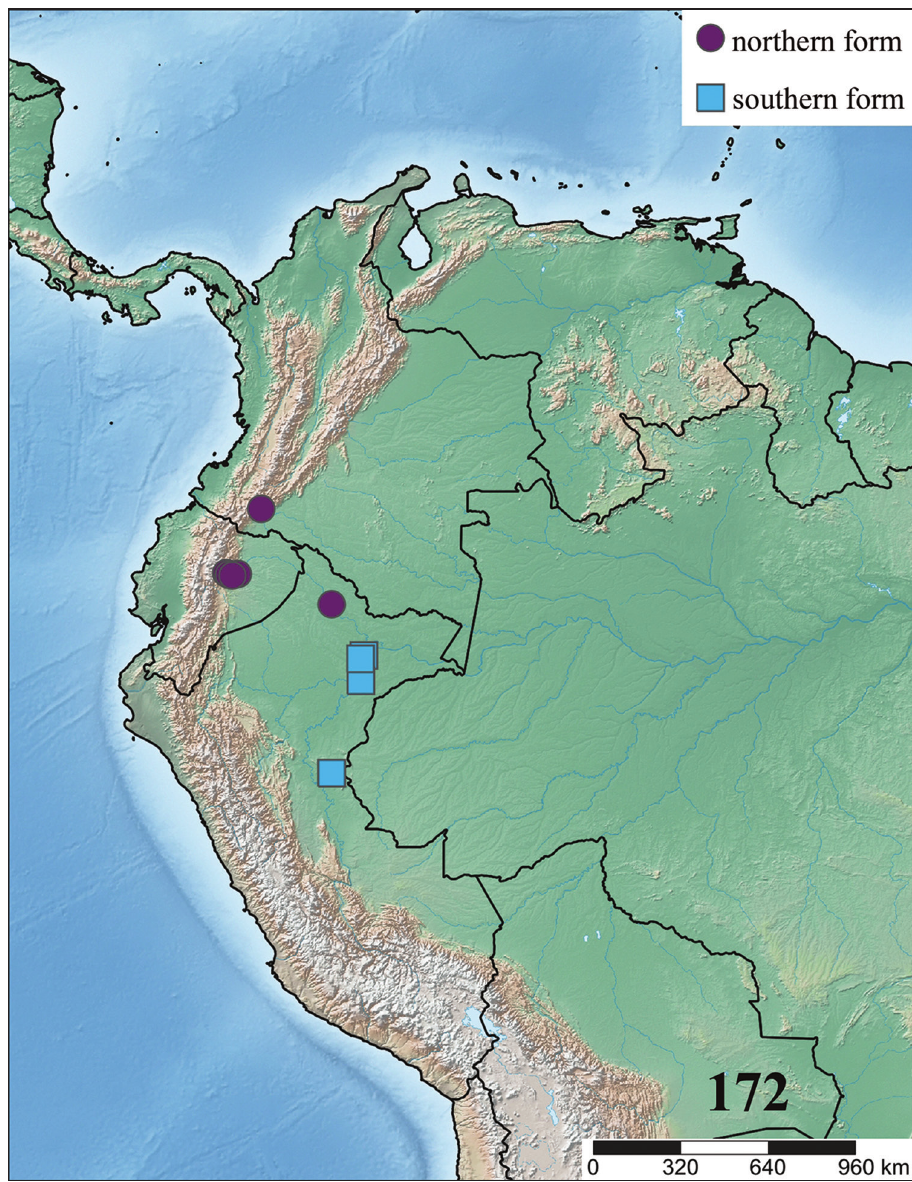
Figure 172. Map showing records of Avicularia purpurea Kirk, 1990